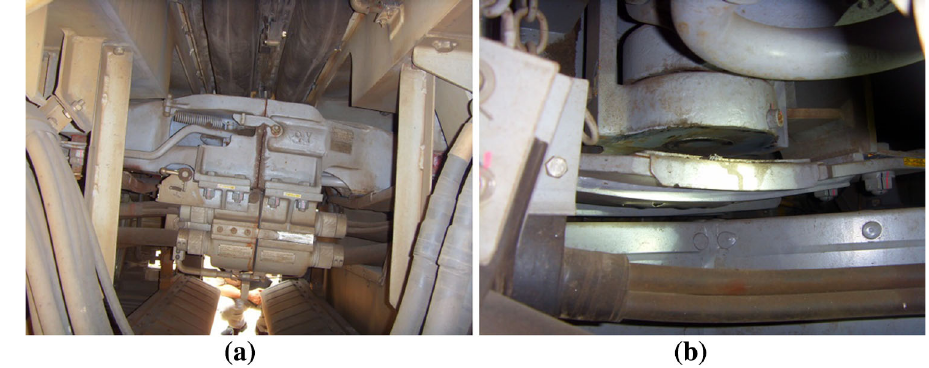
Fig. 4 Illustration of braking-induced impact during train to train rescue test. a Coupler pitching behavior. b Local destructions